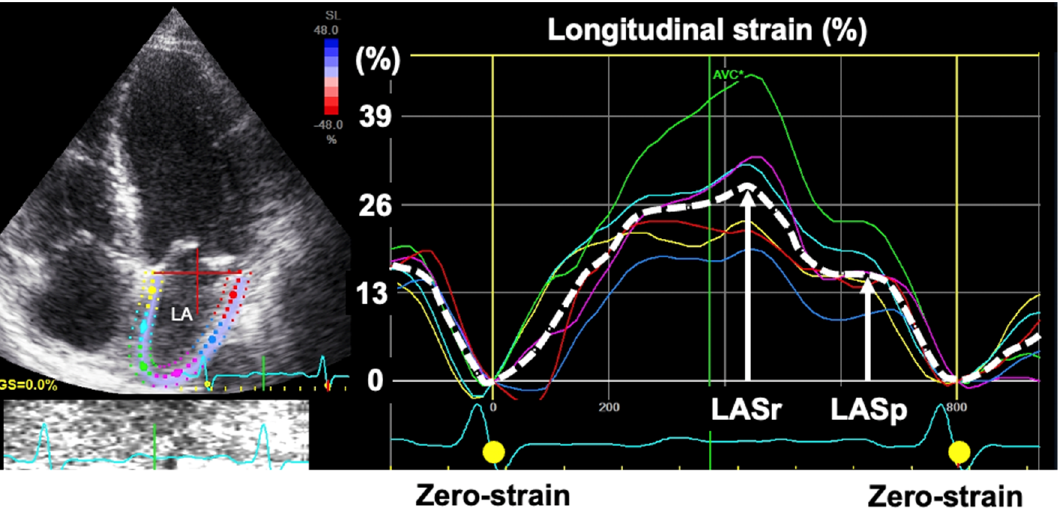
Figure 2. Calculation of left atrial strain. LA strain can be analyzed from a non-foreshortened apical four-chamber view. The zero-strain reference is set at end-diastole according to the recommendation by Badano et al. [17], enabling one to obtain LA strain value even in patients with atrial fibrillation. LA reservoir strain (LASr) is calculated as difference between end-diastole and onset of early LV filling, while LA pump strain (LASp) as difference between onset of atrial contraction and onset of late LV filling. LA, left atrial, LV, left ventricular.